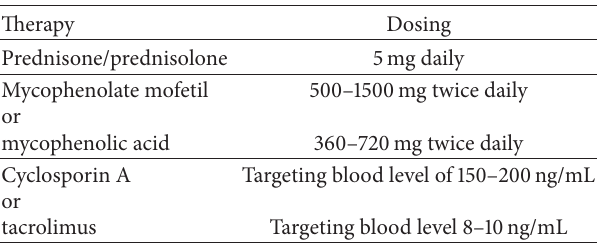
Table3:Typicalbaselineimmunosuppressionbeyondoneyearafter lung transplantation ∗ .